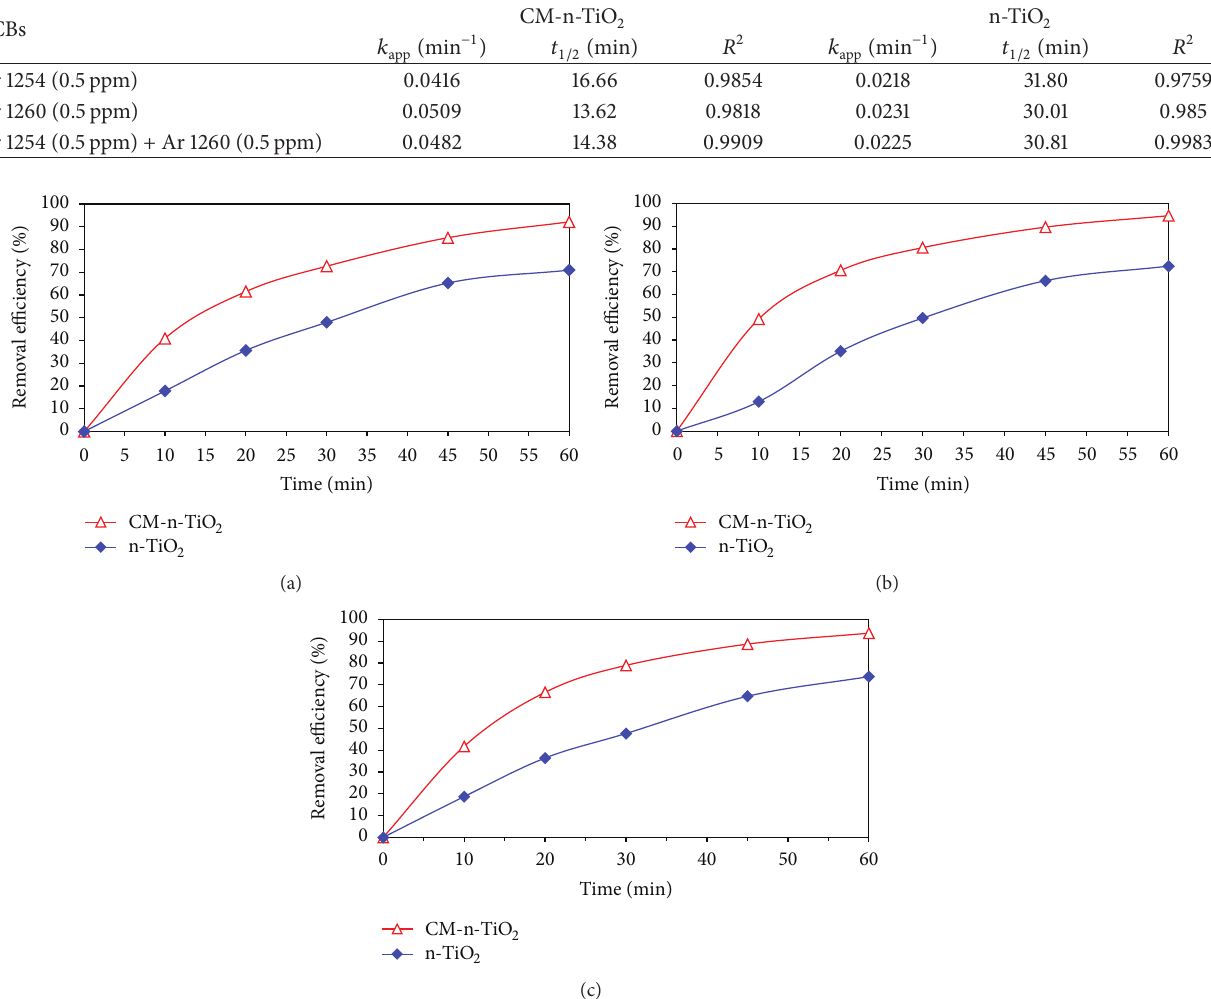
Figure 6: Photocatalytic degradation of (a) Ar 1254 (0.5ppm), (b) Ar 1260 (0.5 ppm), and (c) mixture of Ar 1254 (0.5 ppm) and Ar 1260 (0.5 ppm) in seawater at the optimal conditions of pH 5 and 0.5 gL −1 of the photocatalyst (n-TiO 2 and CM-n-TiO 2 ) under illumination of natural sunlight using the pilot plant